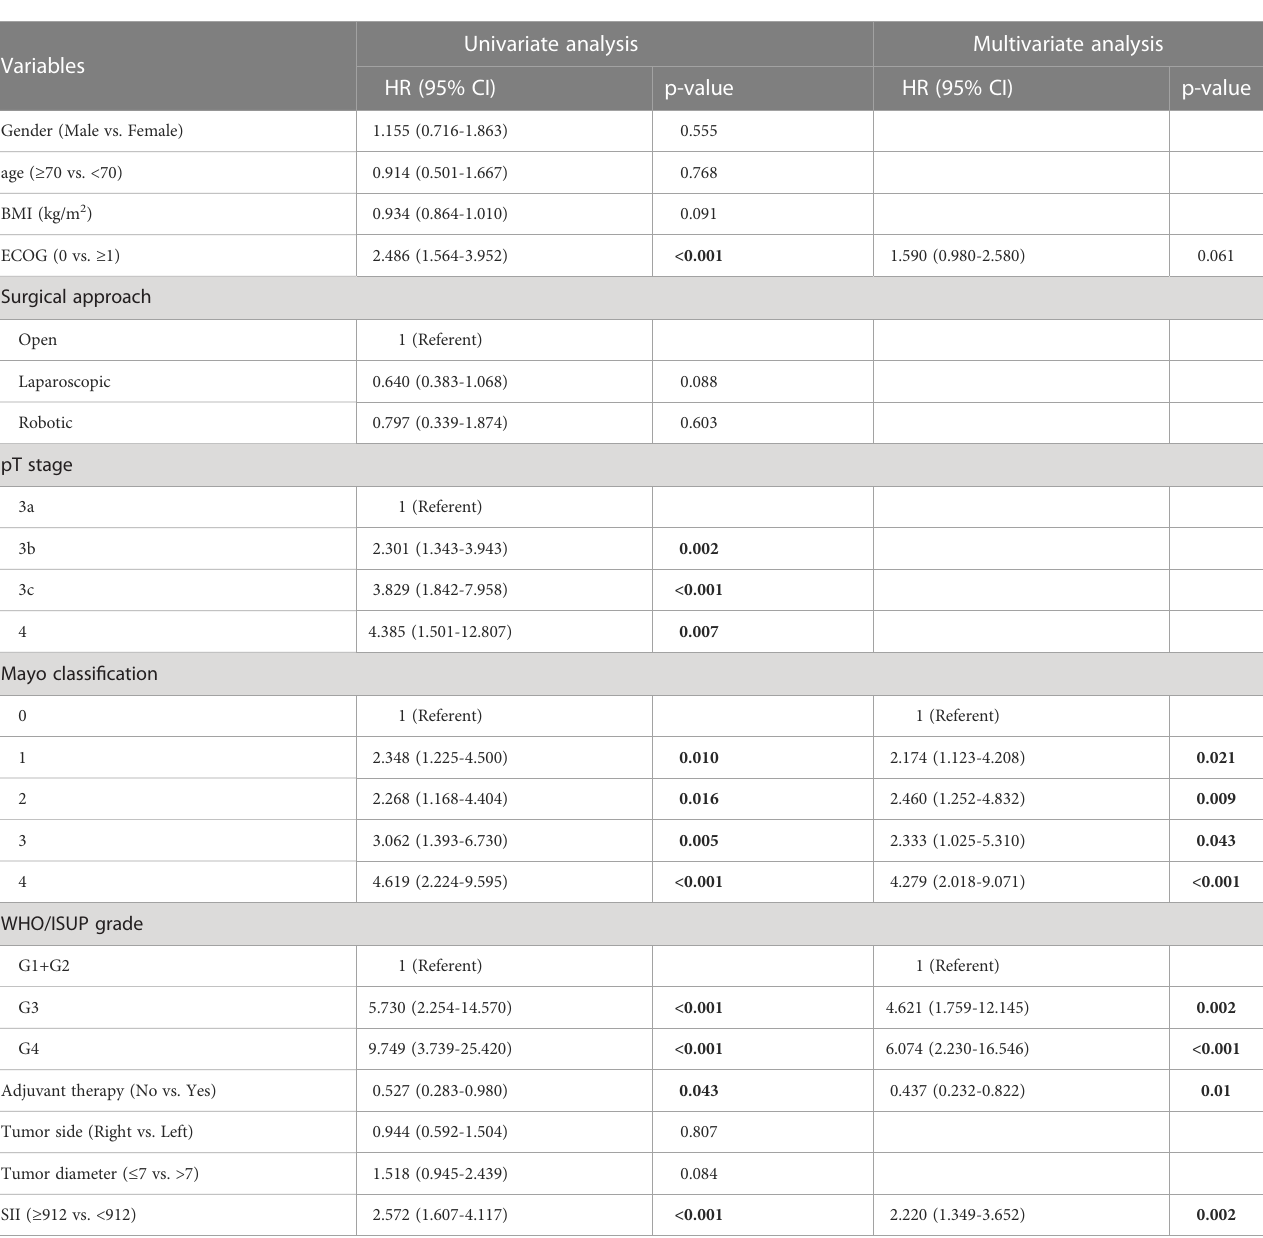
TABLE 2 Univariate and multivariate Cox analyses for OS.